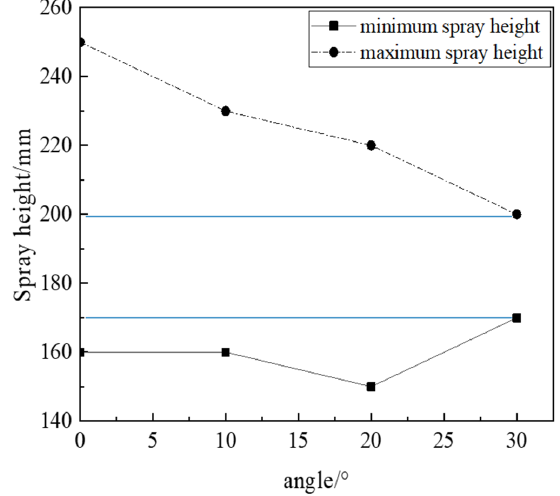
Figure 12. Effective spraying height of each